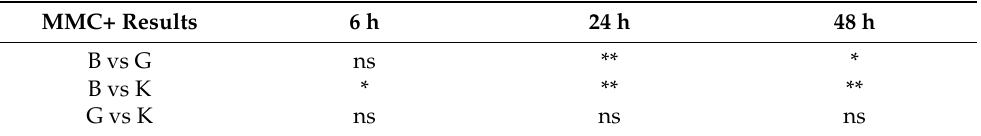
Table 2. Significant level for HaCaT migration assay, in presence of mytomycin ( n = 5, ANOVA,